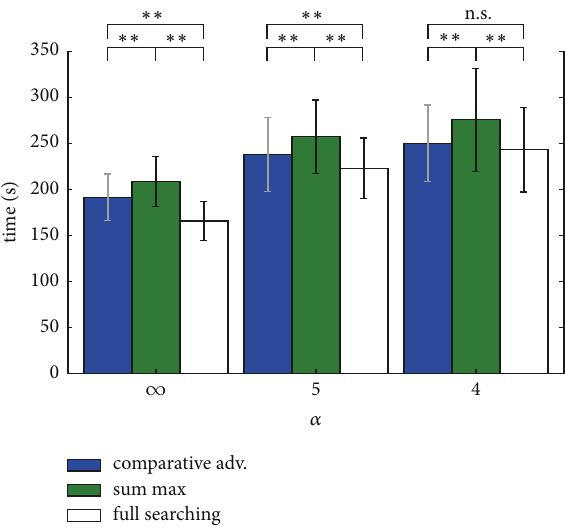
Figure 22: Makespan in situations where carrying objects can be late (three robots). ∗∗ 𝑝 < .01 , ∗ 𝑝 < .05 , and + 𝑝 < .1 . A significant 𝑝 value indicates that a significant difference in prescribing exists between the conditions. The lower 𝑝 value indicates a strong significant difference. n.s. means no significant difference between the